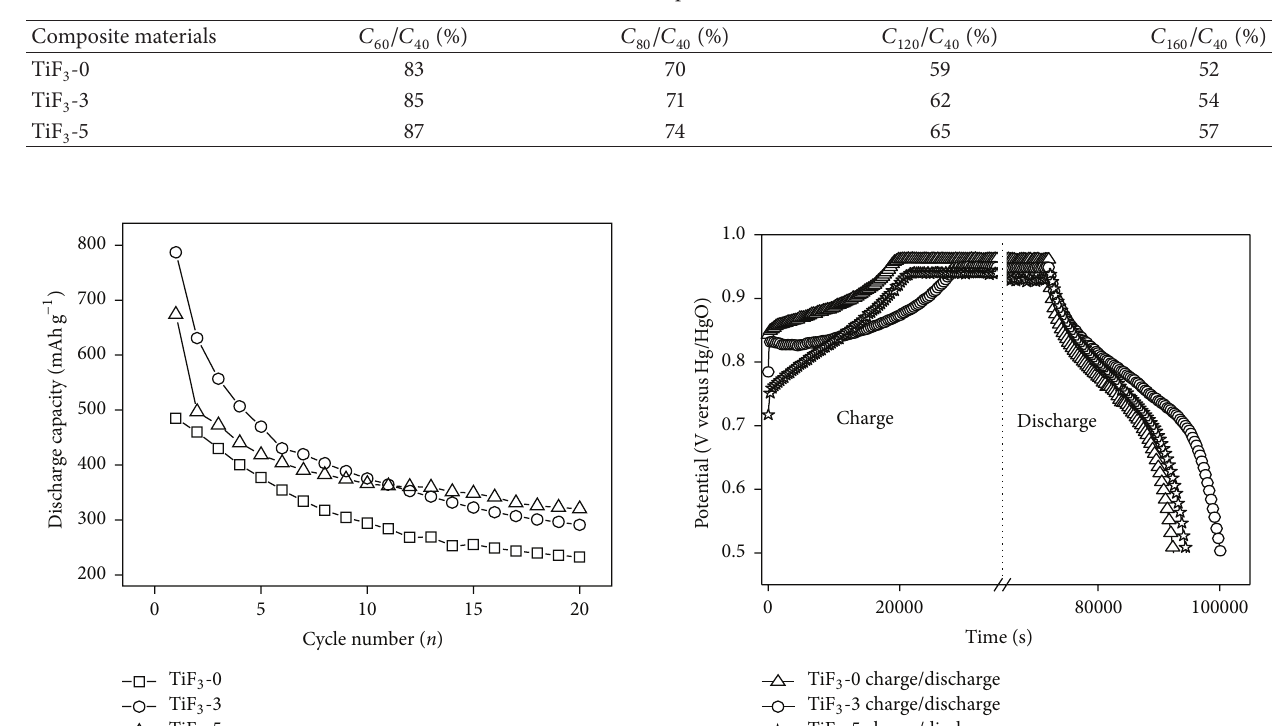
Table 1: HRD values of milled composites as electrode materials.